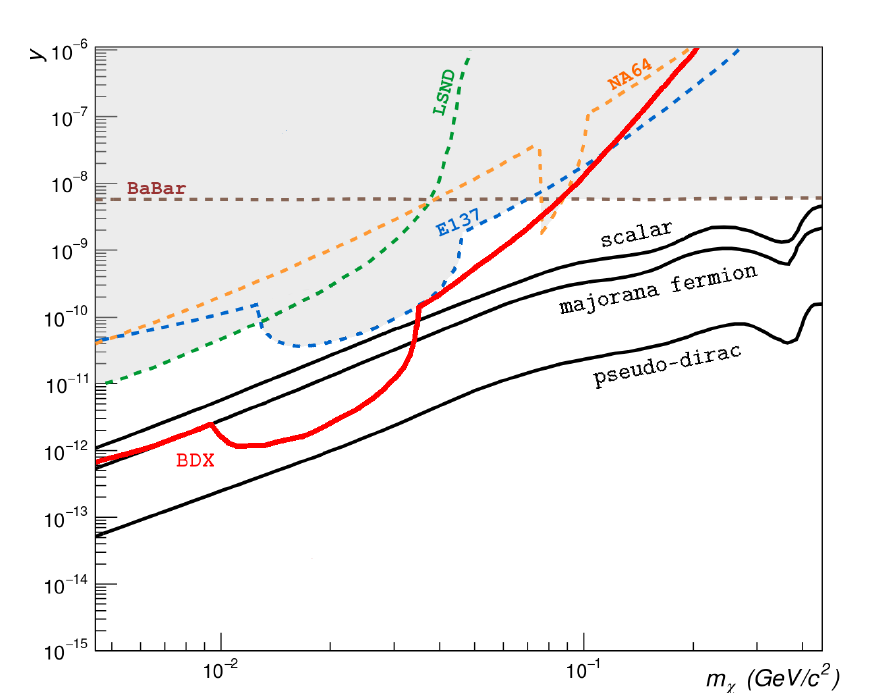
Figure 6. BDX exclusion limits (red line) from Ref. [14]. Limits are given for the parameter y = α D (cid:101) 2 ( m χ / m A (cid:48) ) 4 as a function of m χ , assuming α D = 0.5 and m A (cid:48) = 3 m χ . Black lines indicate various thermal relic